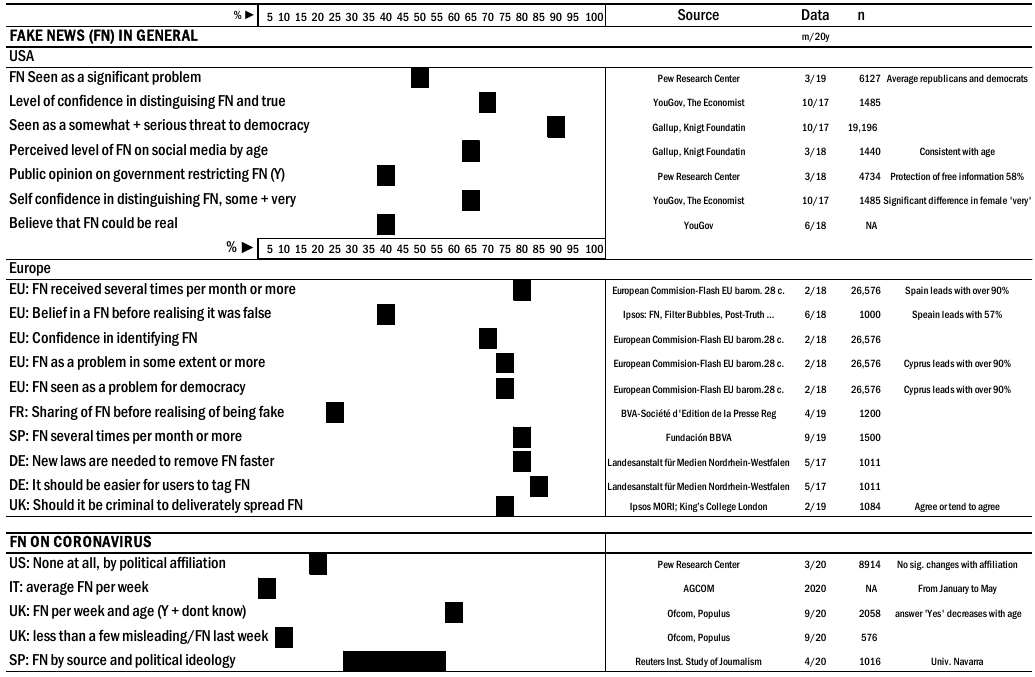
Figure 1. Summary of citizen opinion from different countries related to false news, including fakes on COVID-19. Source: Authors’ computation from different surveys procured from the Statista database.